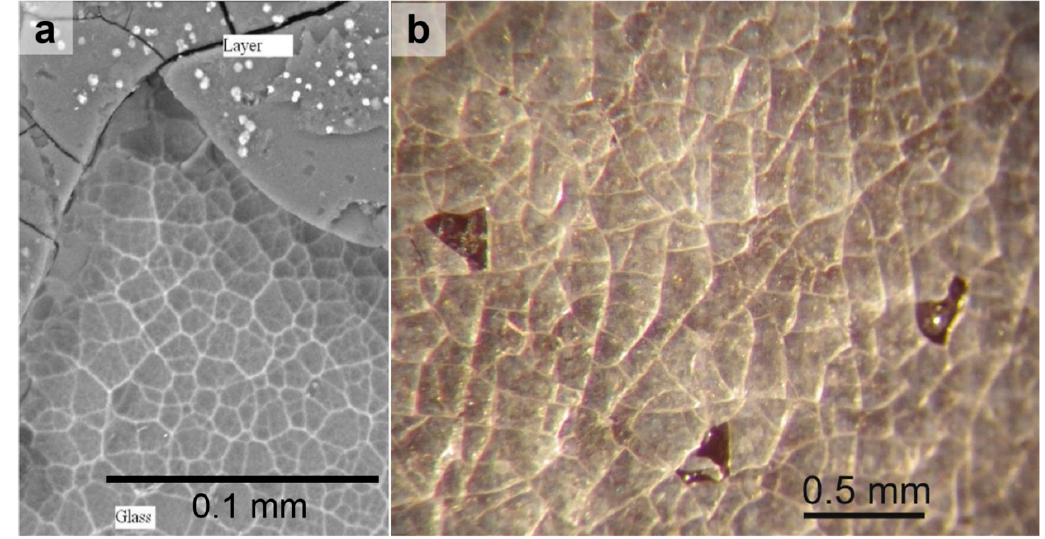
Figure 8. 137 Cs bearing borosilicate glass after 16 years of in-situ testing with a cumulative dose of less than 1.2 × 10 5 Gy ( a ); Na-Al-P glass irradiated by 60 Co up to a cumulative dose of 6.2 × 10 7 Gy ( b ).